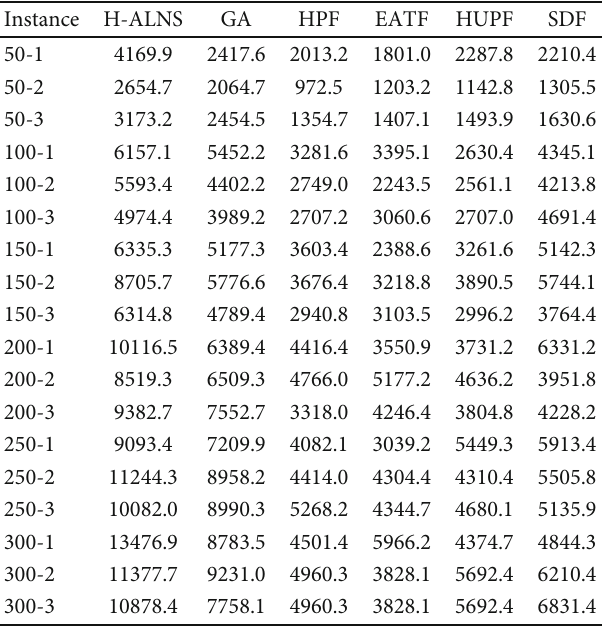
Table 4: Results of pro fi t under small-scale examples.